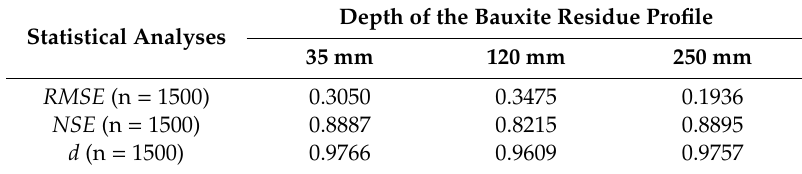
Table 3. Statistical comparison of observed and simulated data for evaluation of inverse modelling. Statistical